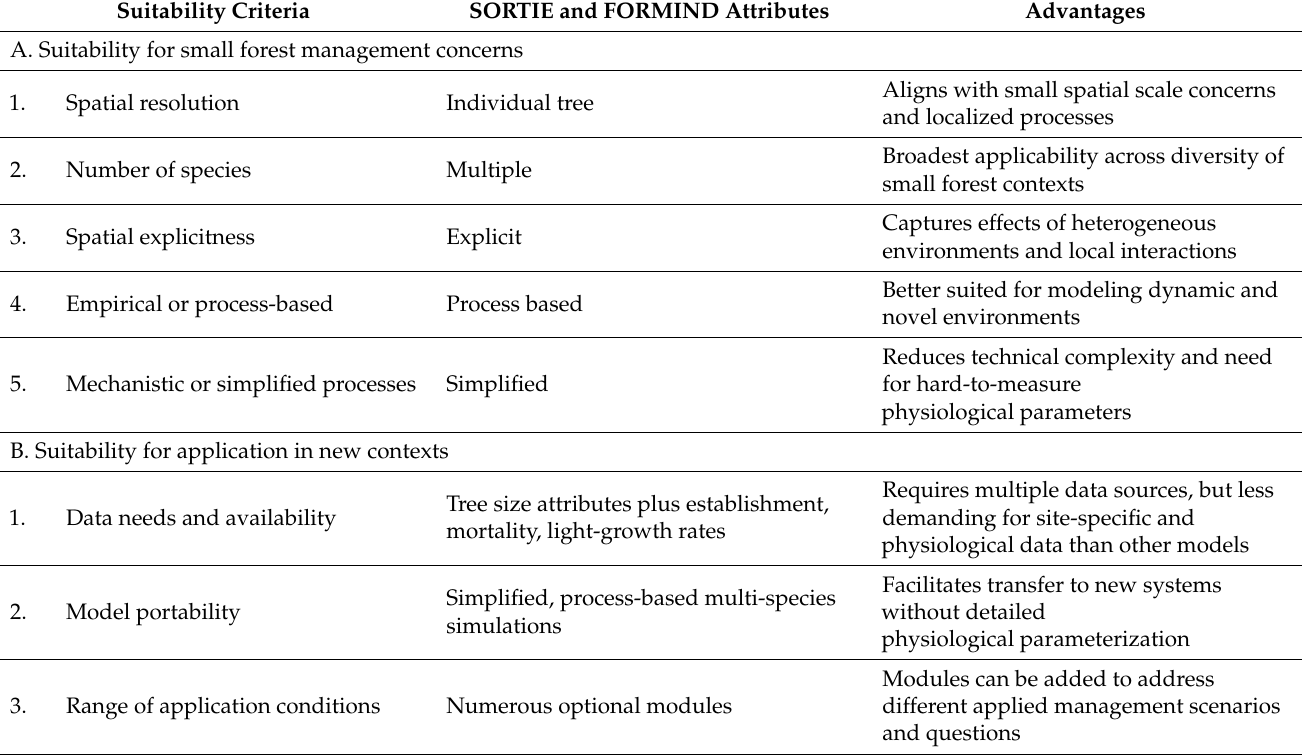
Table 2. Summary of advantageous attributes of SORTIE and FORMIND, in terms of criteria for ( A ) suitability for small forests and for ( B ) application in new